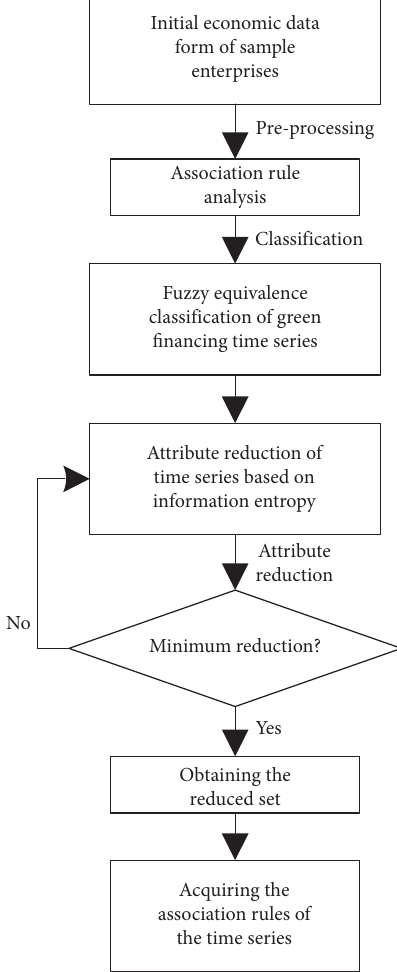
Figure 4: Flow of our association rule analysis algorithm. Table 1: Clustering results of different